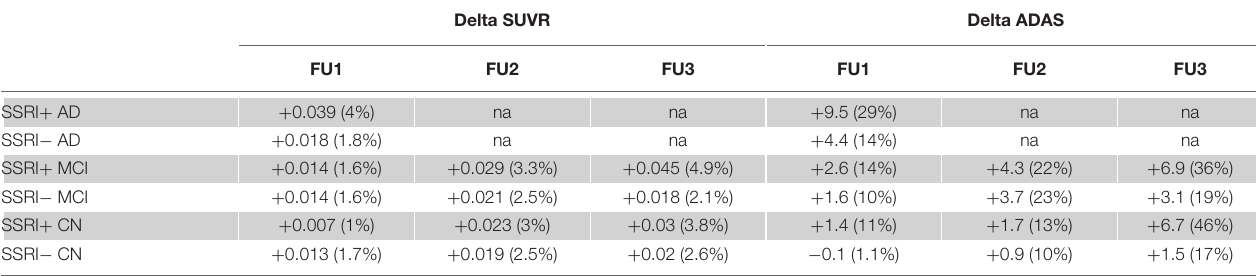
TABLE 3 | Follow up SUVR and